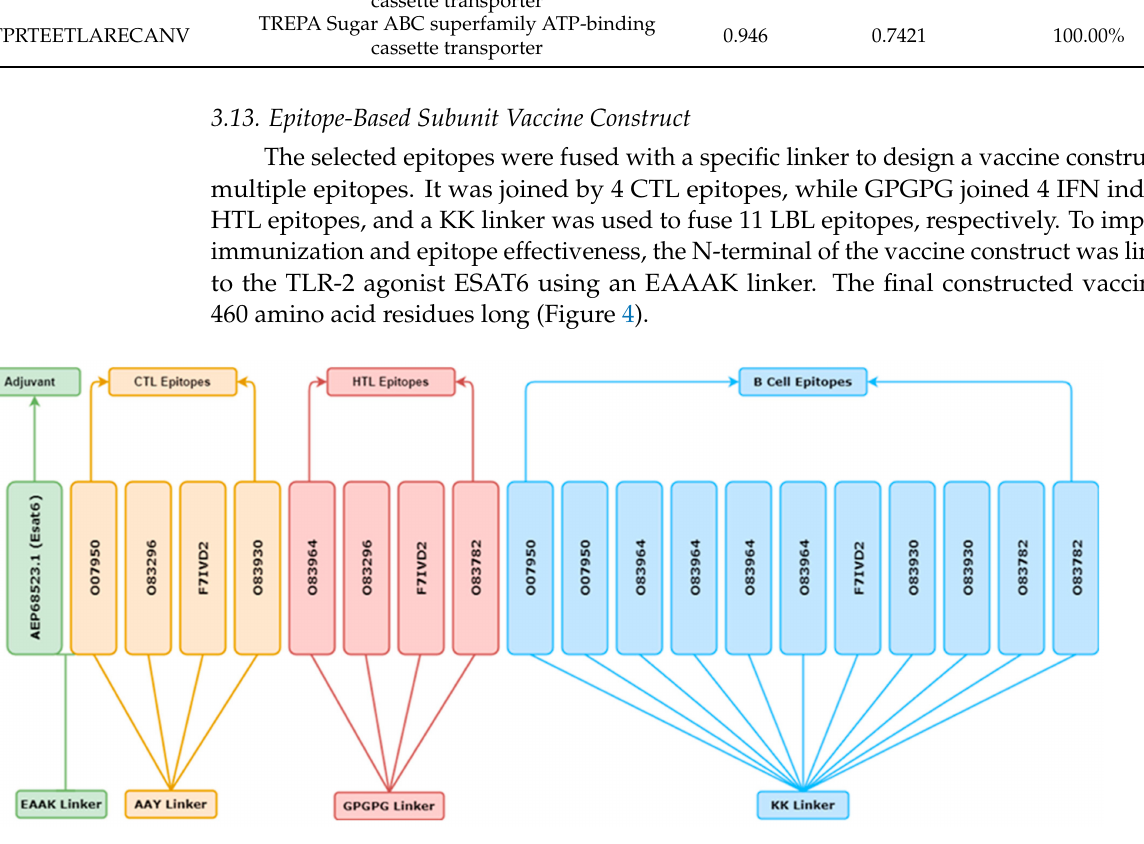
Figure 4. EAAAK, AAY, GPGPGP and KK linkers were used to create the final vaccine candidate configuration, consisting of an adjuvant accompanied by cytotoxic T lymphocyte (CTL), Helper T lymphocyte (HTL), and B cell